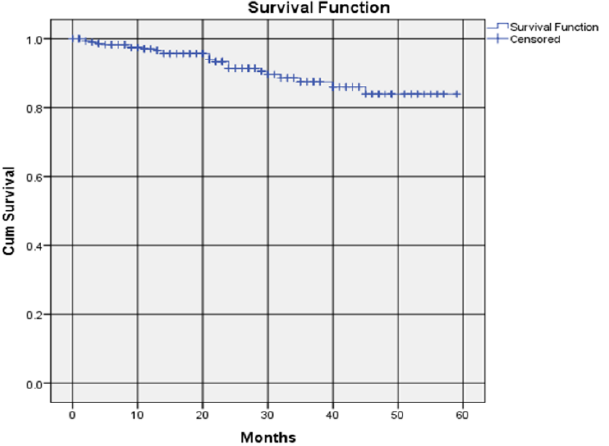
Figure 2. Survival rate of all PFM and metal crowns placed by students.